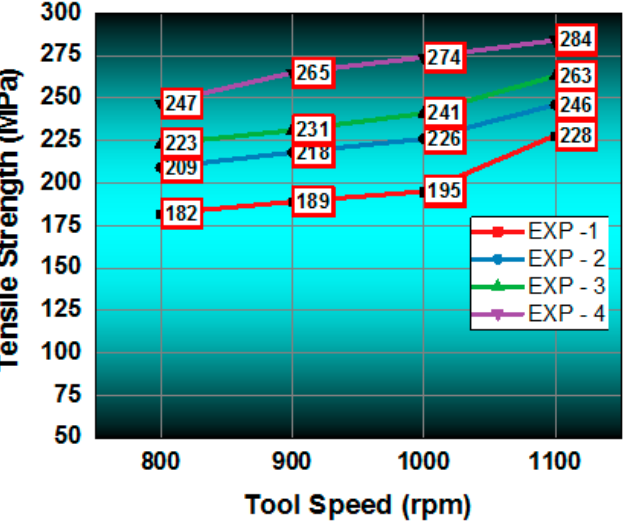
Figure 5. Average tensile strength of the welded joints at various stirring speeds.